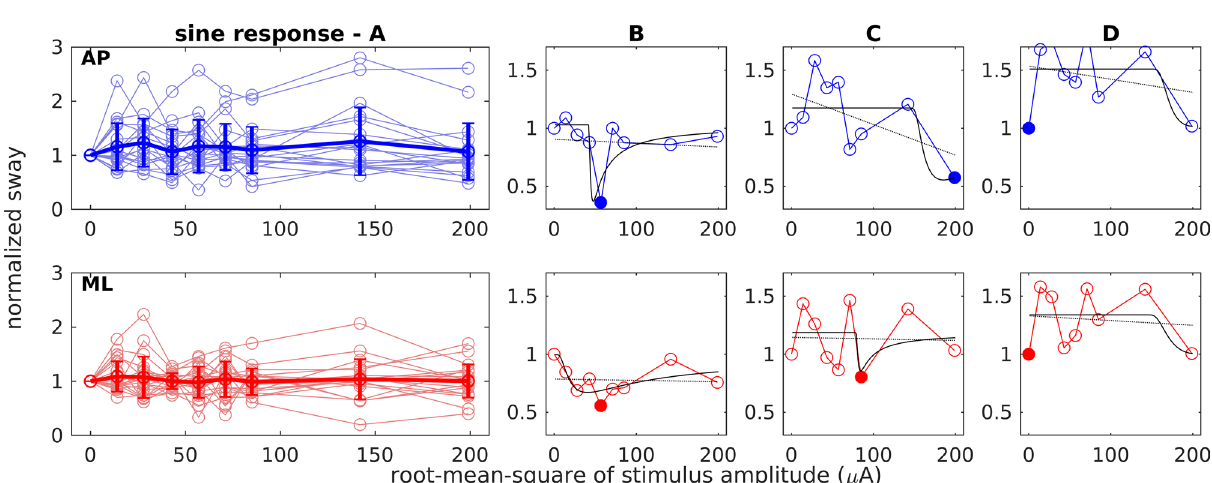
Figure 5. Normalized body sway response amplitudes for standing during sinusoidal platform tilts at varying nGVS intensities. Top row (AP, blue) shows anterior–posterior sway. Bottom row (ML, red) shows medio-lateral sway. ( A ) Responses of all subjects (light circles and lines) with group mean and standard deviation (thick line). ( B–D ) Three exemplary individual responses including the linear (grey) and the SR curve fit (black). Filled circles indicate minimum values. ( B ) Performance curve showing a SR-like bell-shaped with optimal improvement at an intermediate nGVS intensity. ( C ) Performance curve showing only optimal improvement at a particular nGVS intensity. ( D ) Performance curve showing none of the